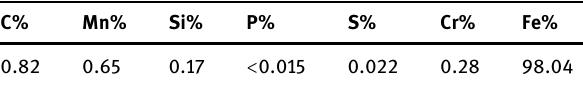
Table 1: Chemical composition of HSHCsw adopted in this study